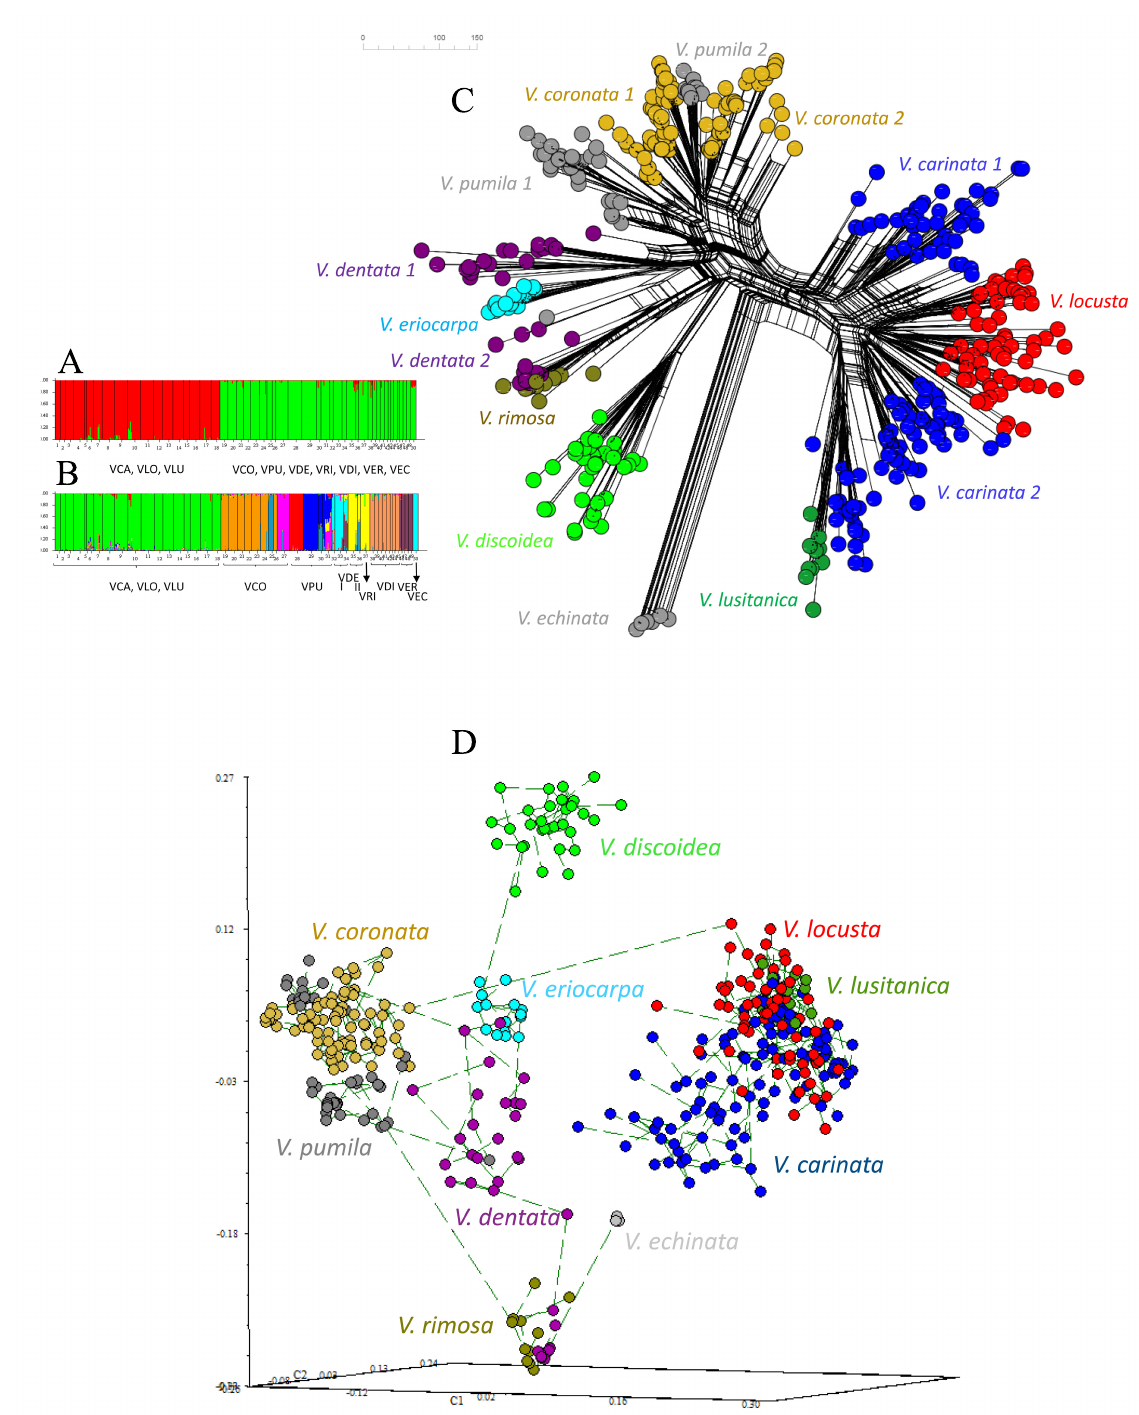
Figure 5. Genetic structure and relationships among 414 individuals of the Valerianella species studied based on total genomic AFLP data. STRUCTURE Bayesian inference analysis for the best K = 2 ( A ) and K = 10 ( B ) hypothetical populations. Neighbor joining network topology ( C ). Three- dimensional PCoA plot with superimposed MST showing the genetic relationships among the 414 individuals of Valerianella ( D ). V . Sect. Valerianella ( V. carinata (VCA), V. locusta (VLO), V. lusitanica (VLU)); V . sect. Coronatae ( V. coronata (VCO), V. pumila (VPU), V. discoidea (VDI)); V . sect. Platycoelae ( V. dentata (VDE), V. rimosa (VRI), V. eriocarpa (VER)); V . sect. Cornigerae ( V. echinata (VEC)). Color codes of Valerianella species correspond to those indicated in Figure